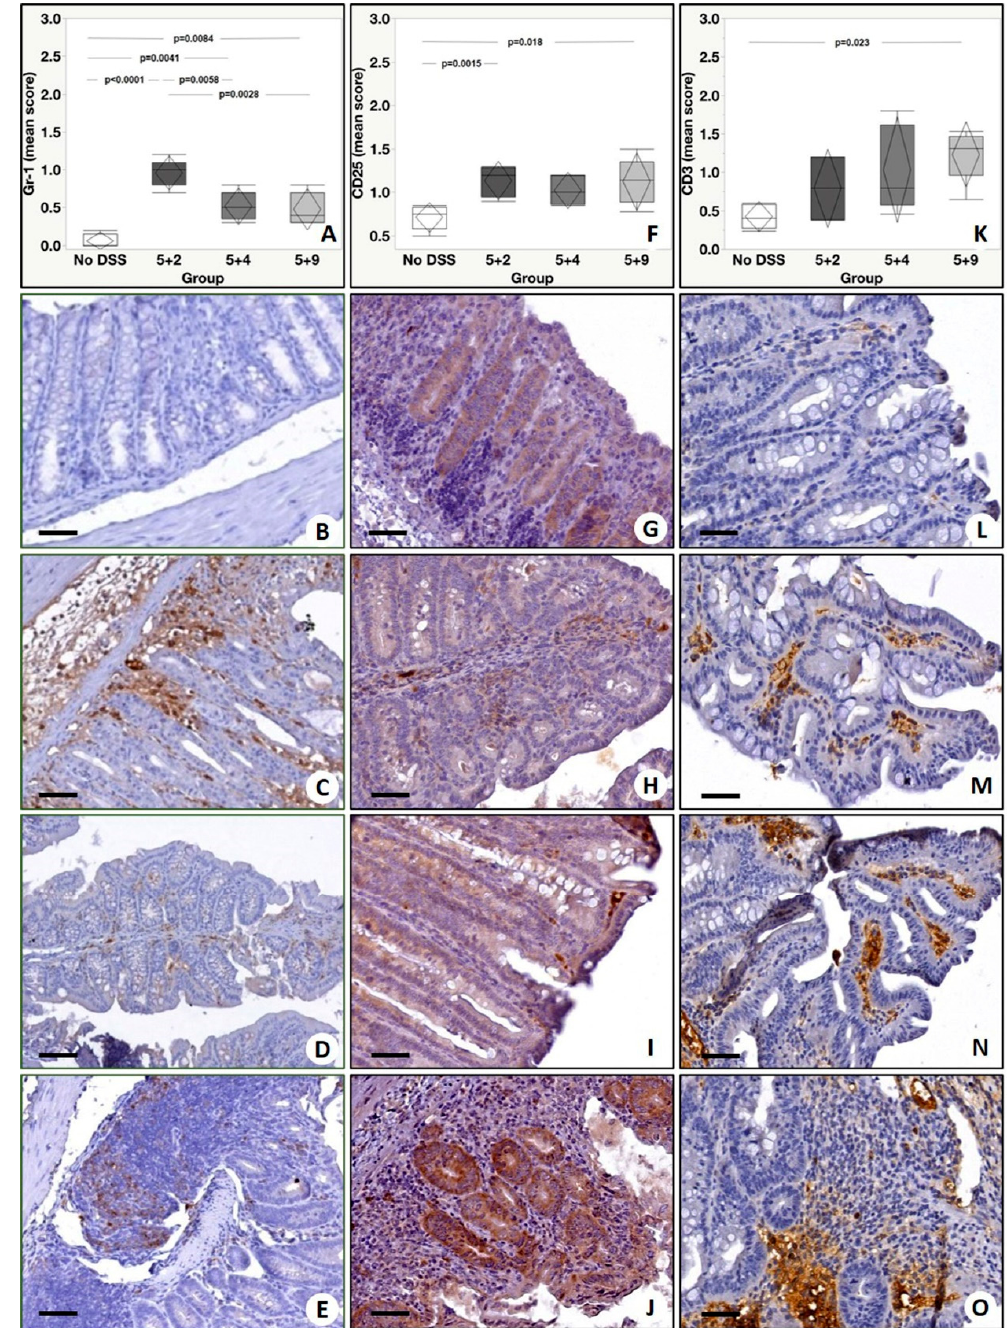
Figure 5. Immunohistochemical evaluation of the expression of Gr-1, CD25 and CD3. ( A ) Graph shows the expression of Gr-1 among the experimental groups. ( B ) No/rare Gr-1 positive inflammatory cells are displayed. ( C ) Numerous Gr-1 positive cells in a colon from 5 + 2 mouse. ( D , E ) Images show some Gr-1 positive inflammatory cells in bowels of 5 + 4 and 5 + 9 mice. ( F ) Graph shows the expression of CD25 among the experimental groups. ( G ) Some CD25 positive cells are displayed. ( H − J ) High/moderate CD25 positive cells in colons from 5 + 2, 5 + 4 and 5 + 9 mice. ( K ) Graph displays the expression of CD3 among the experimental groups. ( L ) Colon from NO DSS mouse shows no/rare CD3 positive cells. ( M,N ) Numerous CD3 positive cells in colons from 5 + 2 and 5 + 4 mice. ( O ) High CD3 positive cells in a colon from 5 + 9 mouse. Scale bar represents 200 µm in each image.